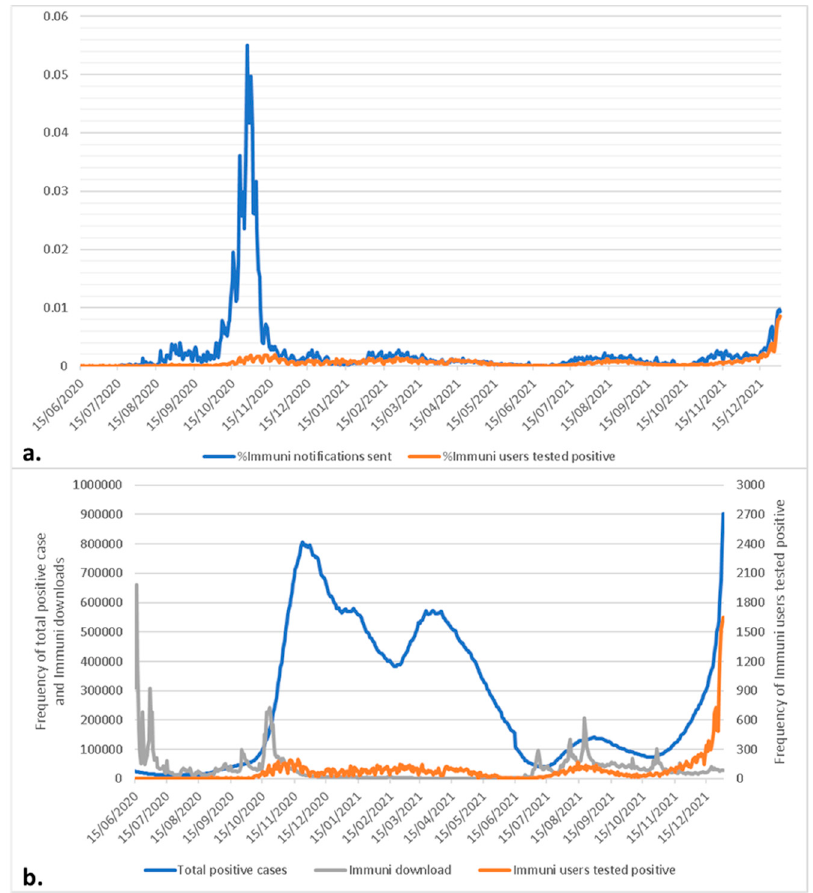
Figure 1. Immuni app data: ( a ) daily percentage of Immuni users tested positive for SARS-CoV-2 and notifications sent by Immuni panel; ( b ) daily frequency of total SARS-CoV-2 positive cases, Immuni downloads (primary axis) and Immuni users tested positive for SARS-CoV-2 (secondary axis) panel. Excluding these two months, the notification trend is flat (trend test p = 0.133) with a slight but not statistically significant increase from December